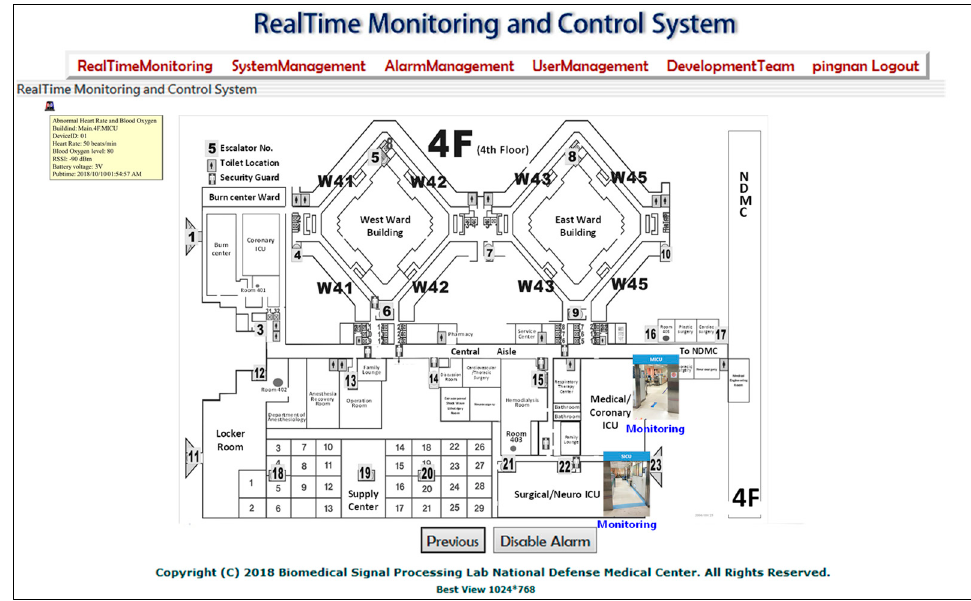
Figure 12. Level 3 contains the monitoring page for ICUs (MICU and SICU) on the fourth floor.